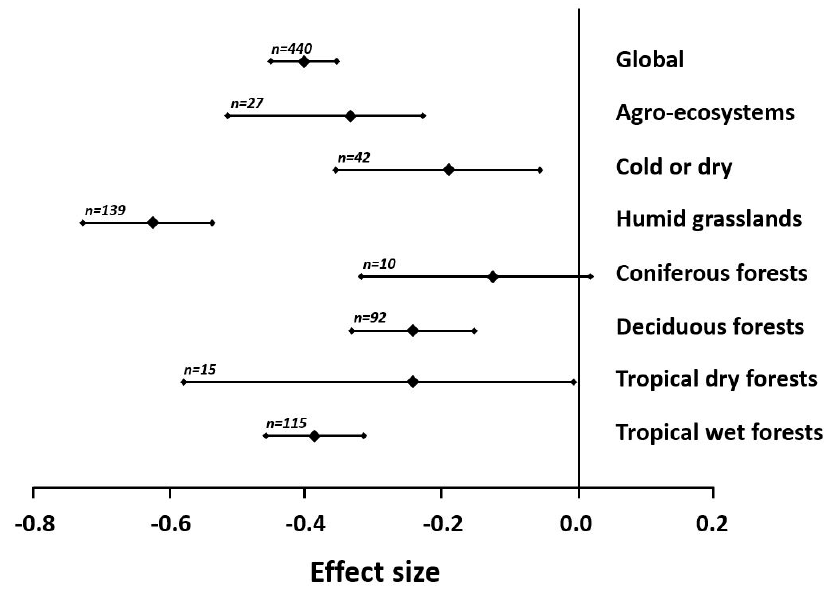
Figure 3. Mean effect size of soil fauna exclusion on litter decomposition rates (lnRR(k)) at the global scale, agro-ecosystems, cold or dry, humid grasslands, coniferous forests, deciduous forests, tropical dry forests, tropical wet forests. The bars around the means are bias-corrected with 95% bootstrap confidence intervals. Negative mean effect sizes indicate slower litter decomposition in the litterbags without soil fauna. Modified from Garcia-Palacios et al. [28]. (Per-mission asked for from the publisher, Wiley.)